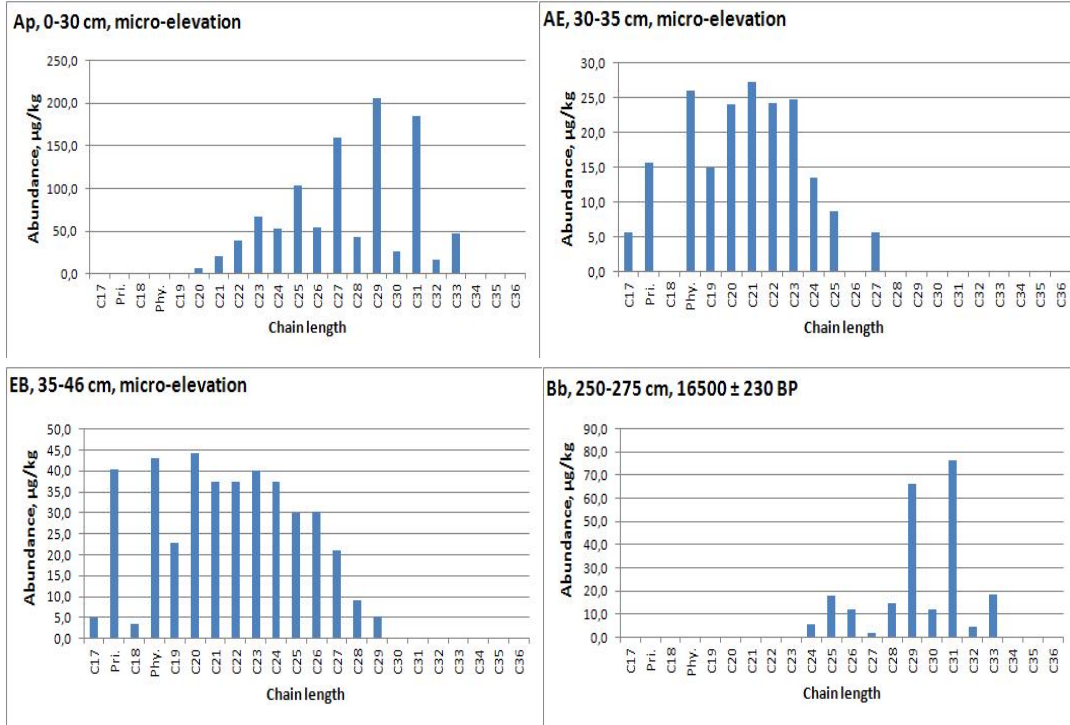
Figure 5. n ‐ alkane distribution in soil of micro ‐ elevation and interstadial soil from loess ‐ paleosol Figure 5. n -alkane distribution in soil of micro-elevation and interstadial soil from loess-paleosol sequence under it. sequence under